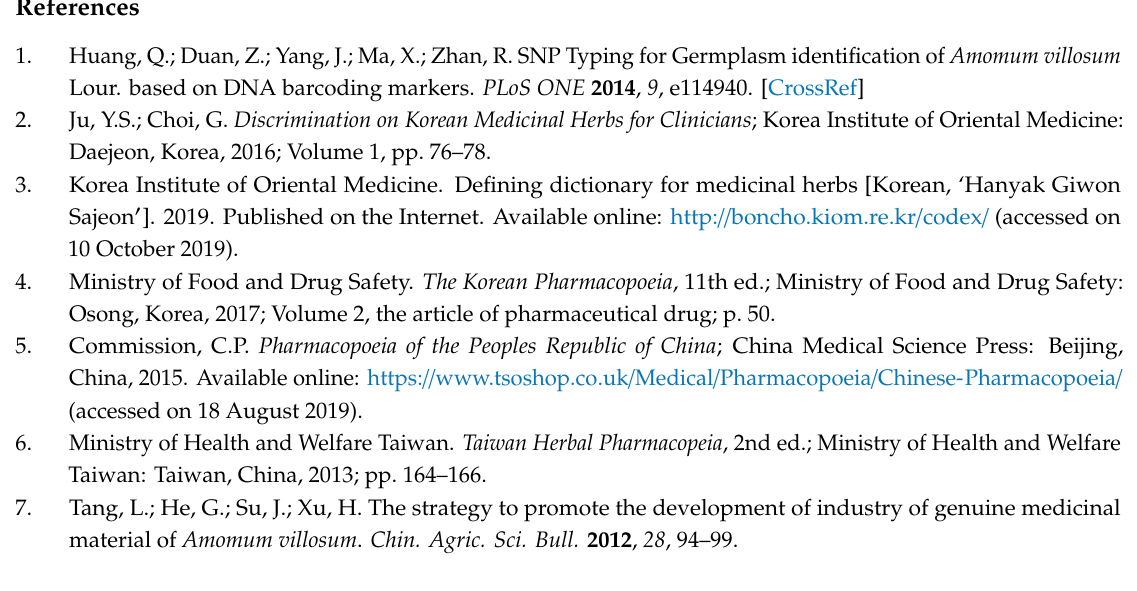
Supplementary Materials: The following are available online. Table S1. The sequence identity matrix among the Amomi Fructus and its several adulterants based on the ITS nucleotide sequence. Table S2. The sequence identity matrix among the Amomi Fructus and its several adulterants based on the four DNA barcode loci in chloroplast genome. Figure S1. Neighbor-joining (NJ) tree of Amomi Fructus and its adulterants based on the Table 1. As outgroups, Brassica rapa and Oryza sativa were